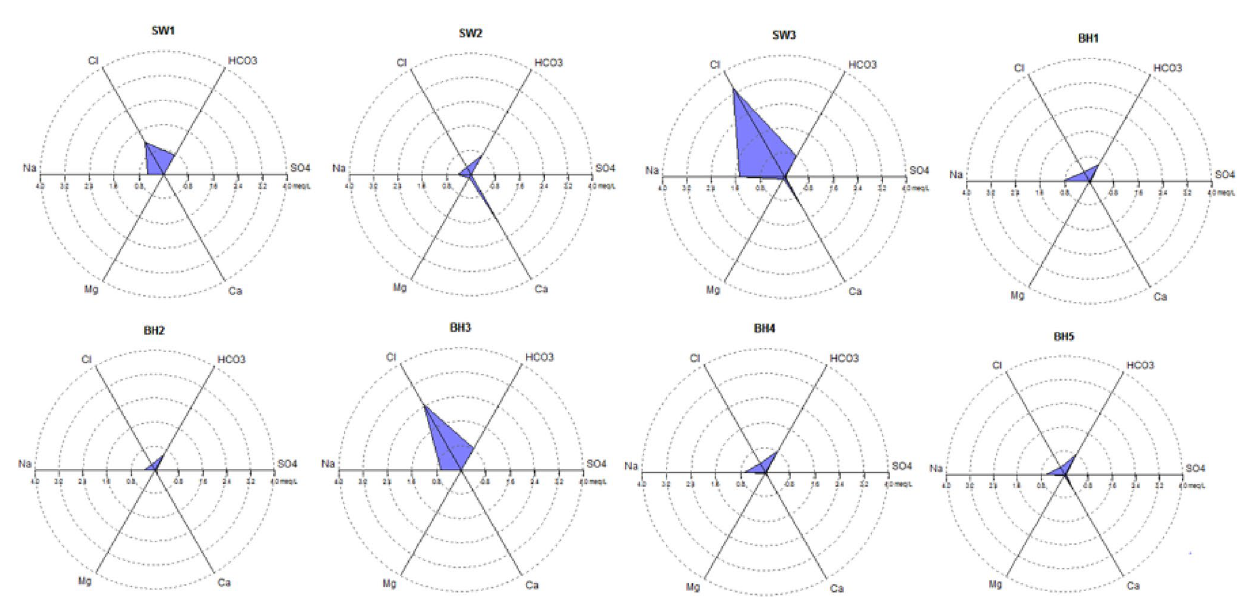
Fig. 4 Radial diagrams for samples SW1, SW2, SW3, BH1, BH2, BH3, BH4 and